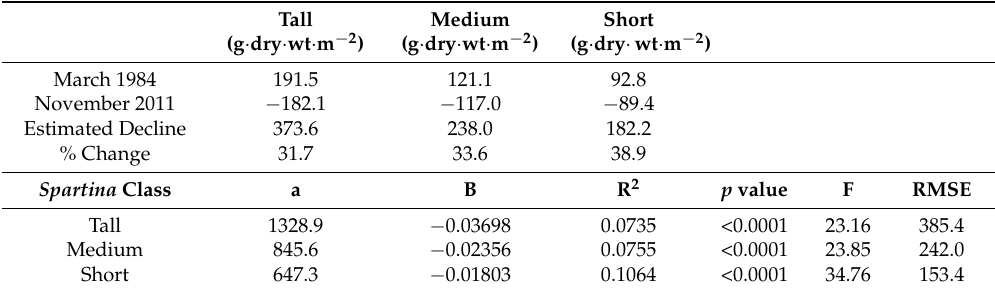
Table 5. Results using deviations from annual phenology calculated from day-of-year values for each image.